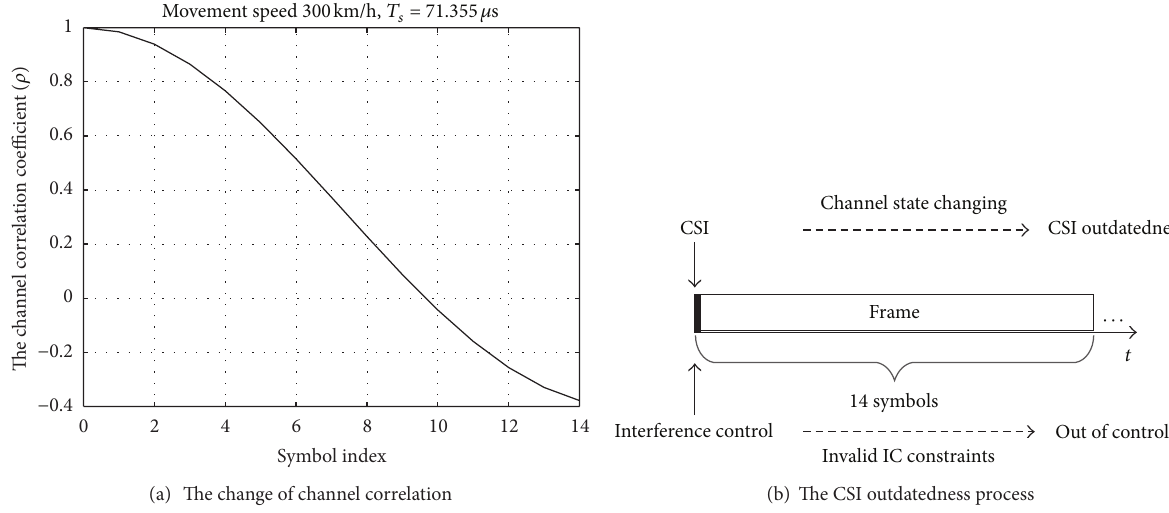
Figure 3: The CSI outdatedness in standard LTE transmission frame.